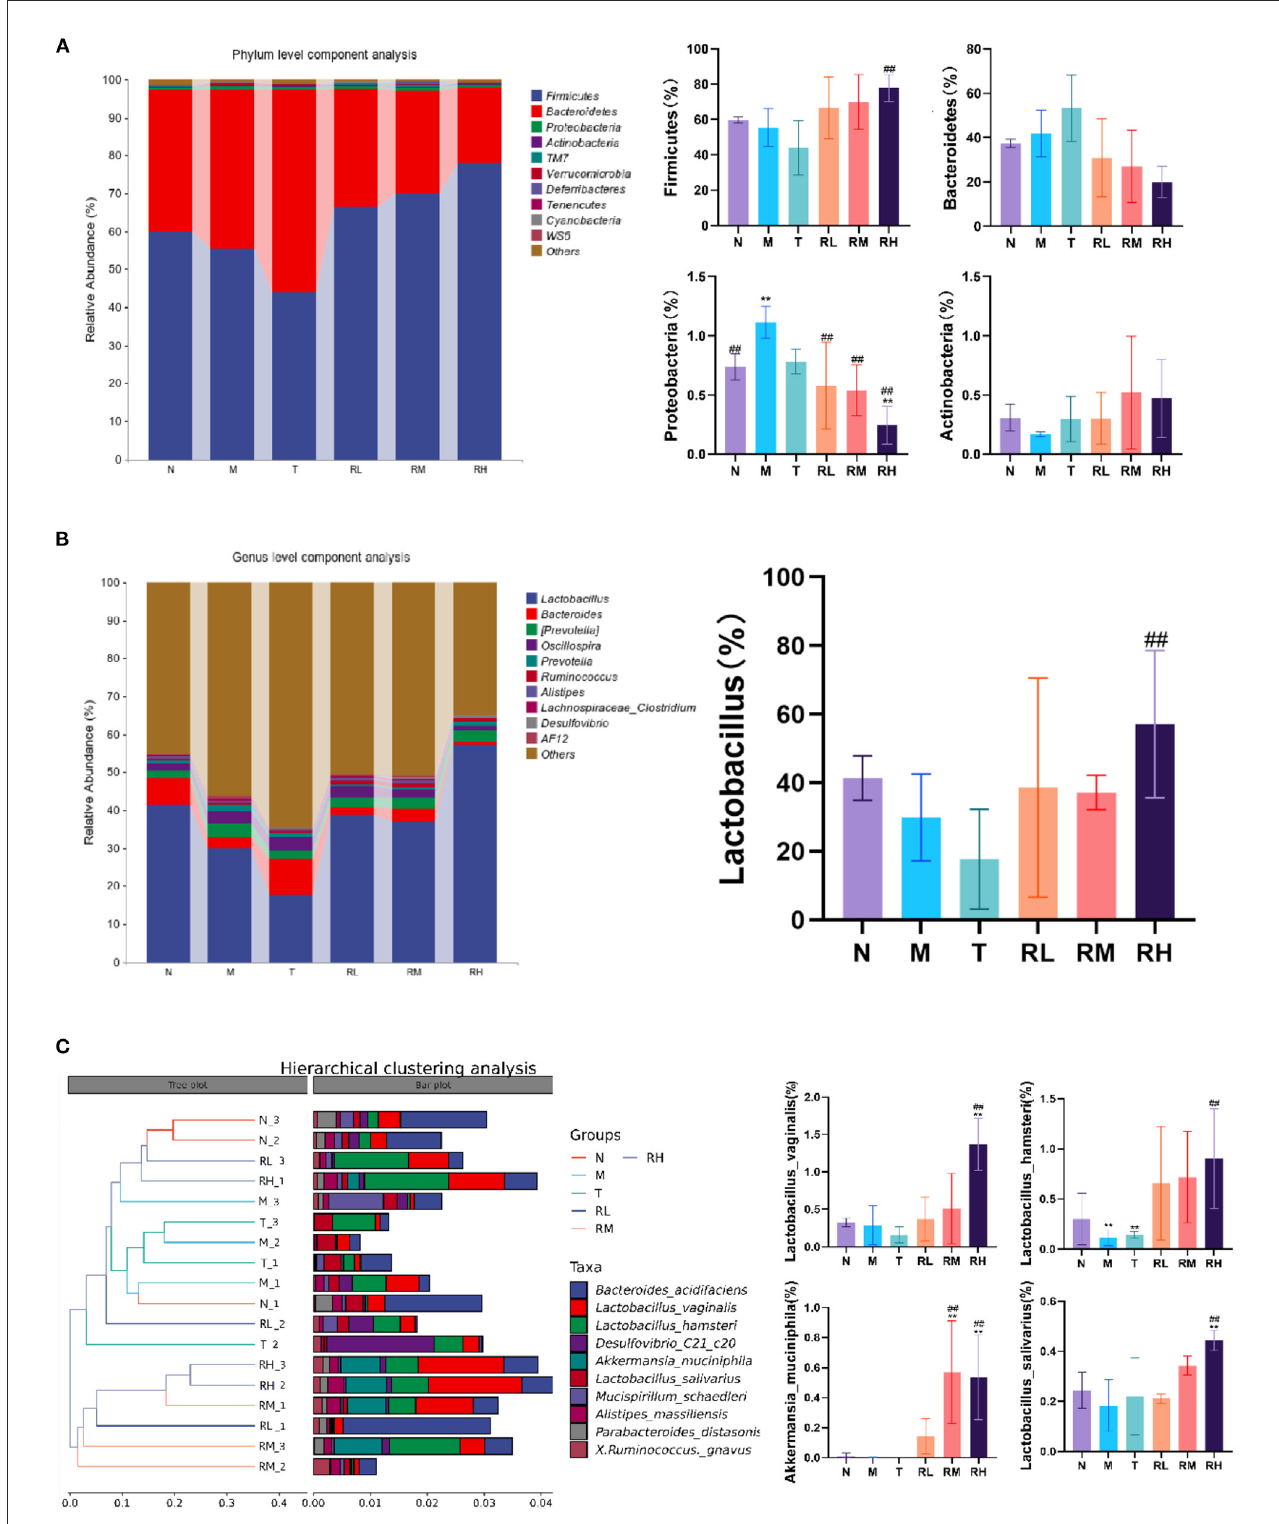
FIGURE8 Effect of RGO on intestinal microflora structure in mice. (A) Phylum level composition analysis. (B) Genus level composition analysis. (C) Species level cluster analysis. Compared with group N: * P < 0.05, ** P < 0.01; compared with group M. # P < 0.05, ## P < 0.01.